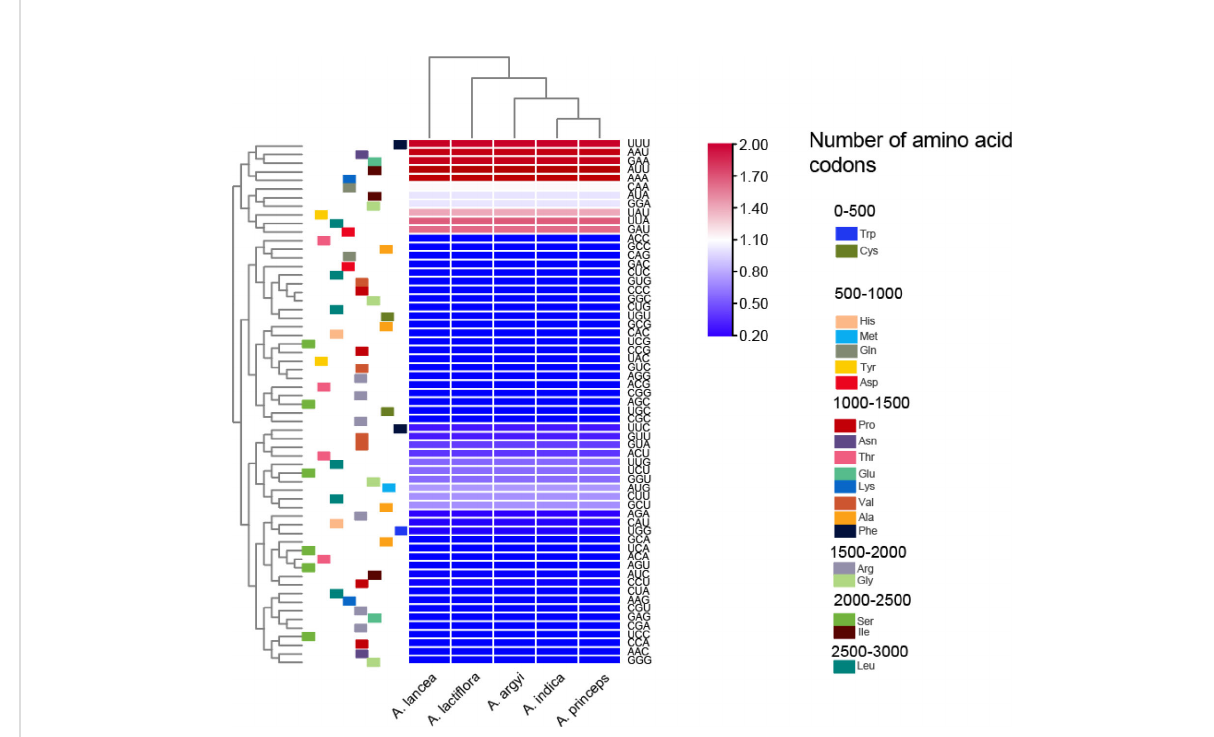
FIGURE 1 Heat map of the relative synonymous codons usage values of the cp genomes in the fi ve Artemisia